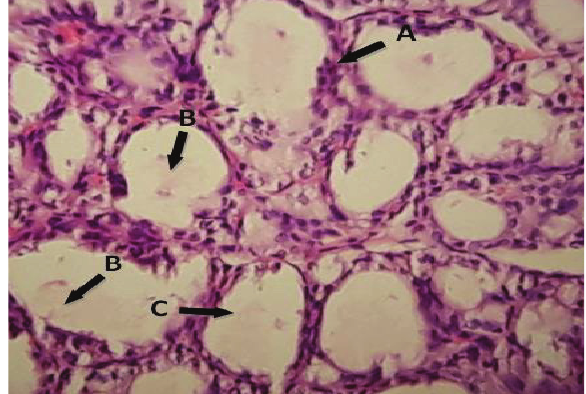
Figure 6: Treated with Thyroxine 0.6μg/100gm BW(G-6) A = Normal follicular epithelial alignment returning B = Partially filled follicles with colloid C = Follicular morphology partially normal D = Focal pyknotic foci seen, not very prominent